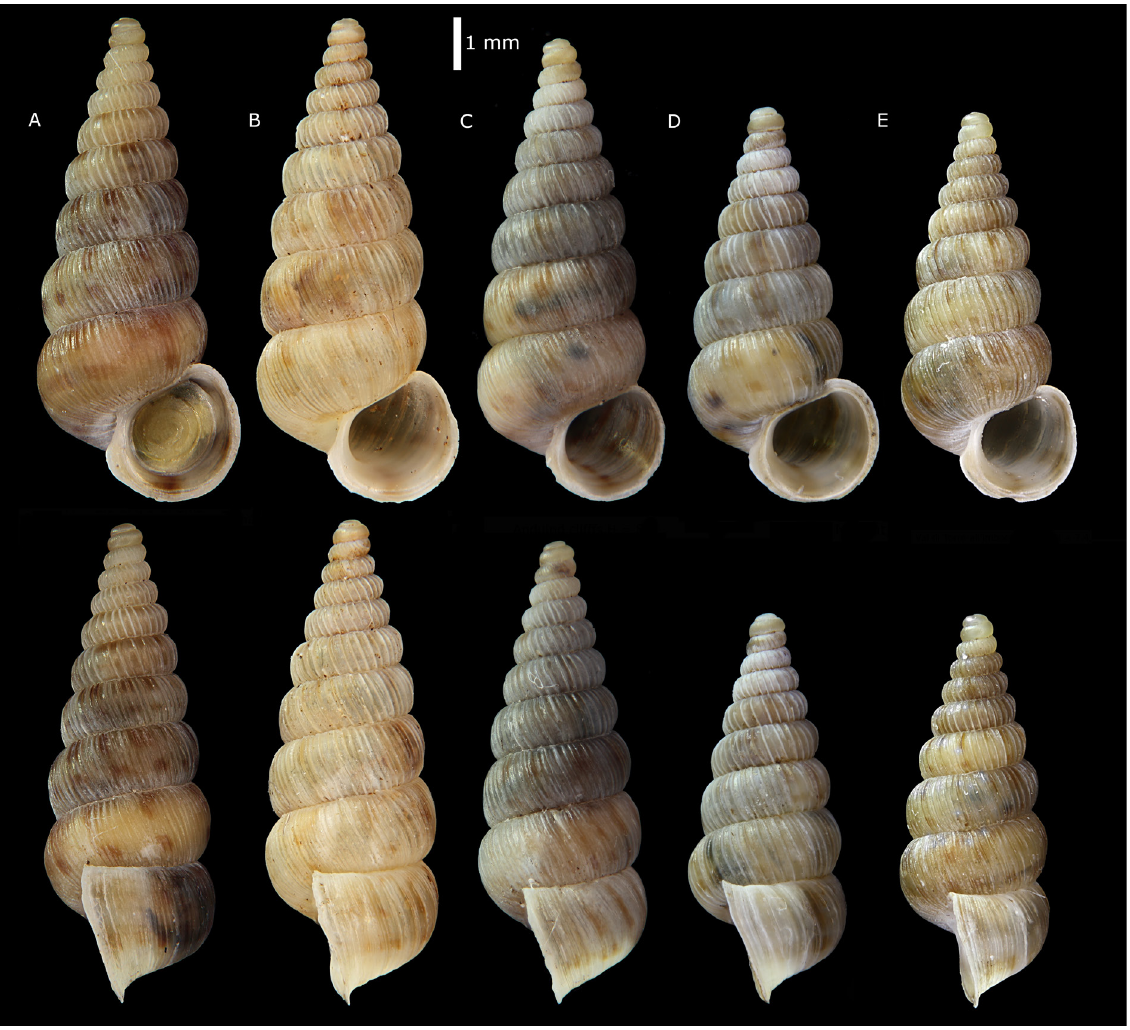
Fig 25. Shell variability in Cochlostoma ( Clessiniella ) stelucarum sp. nov. A . Cornino, Italy (EZ0104). B . Mt Valinis, Italy (EZ0096). C . Anduins, Italy (EZ0102). D . Mt Prat, Italy (EZ0103). E . Val di Torre, Italy